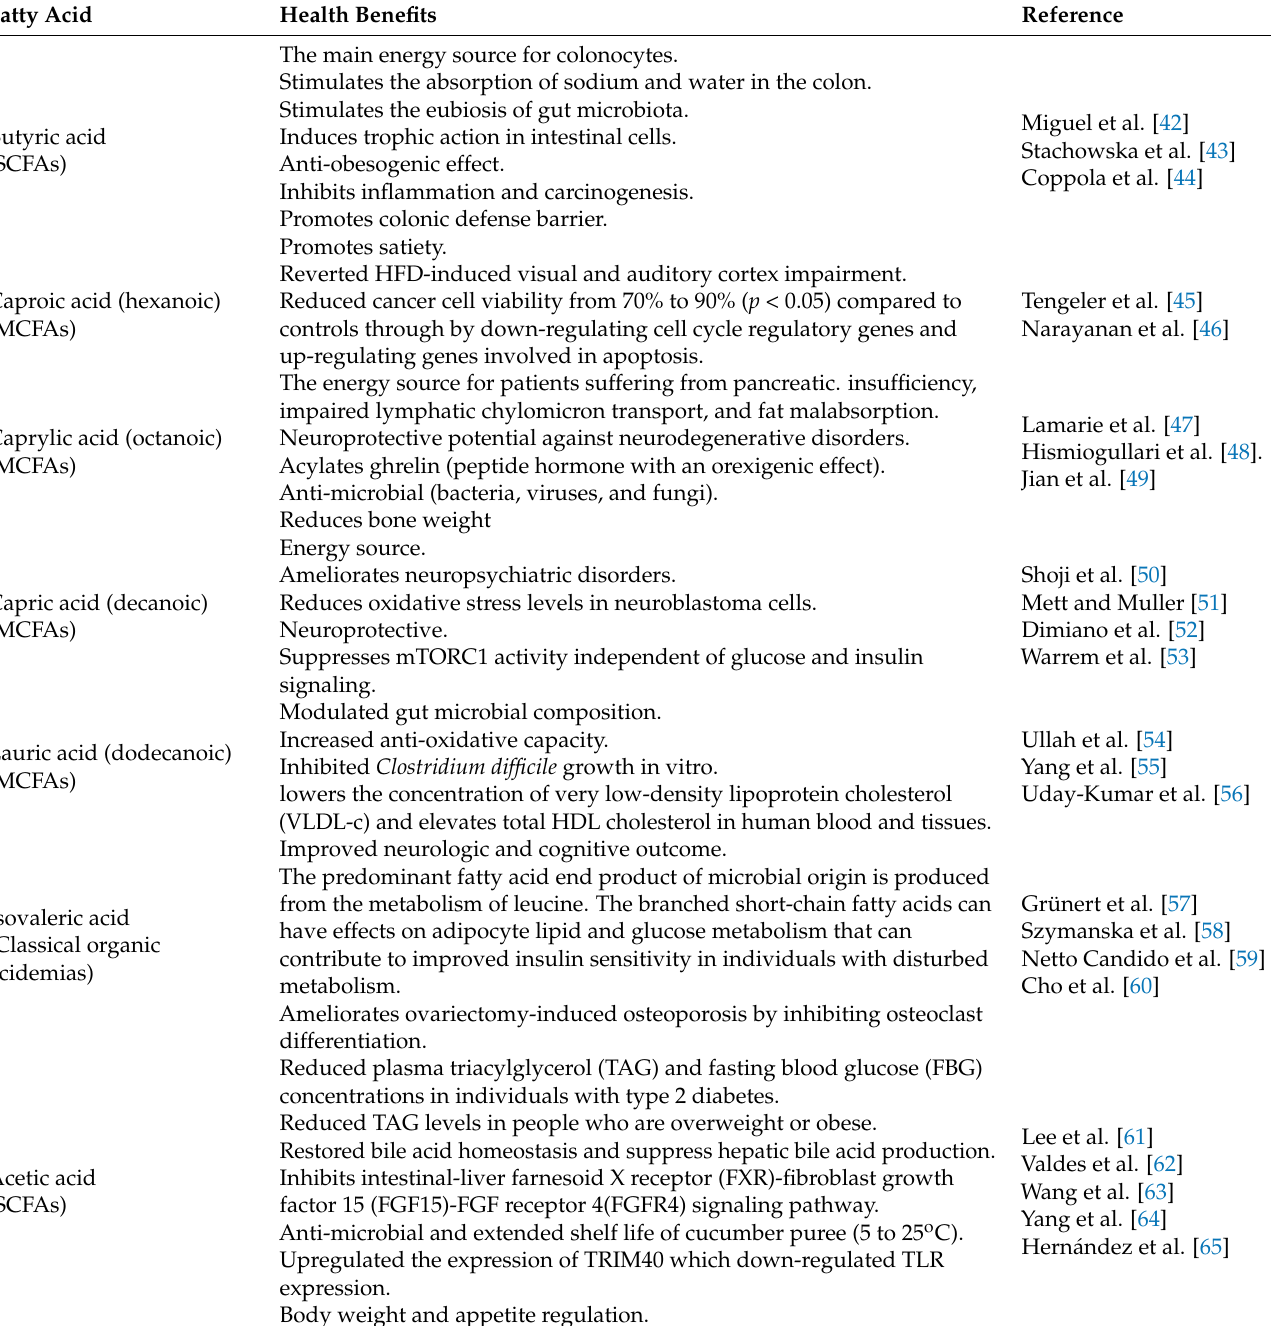
Table 2. Health functions of some dietary fatty